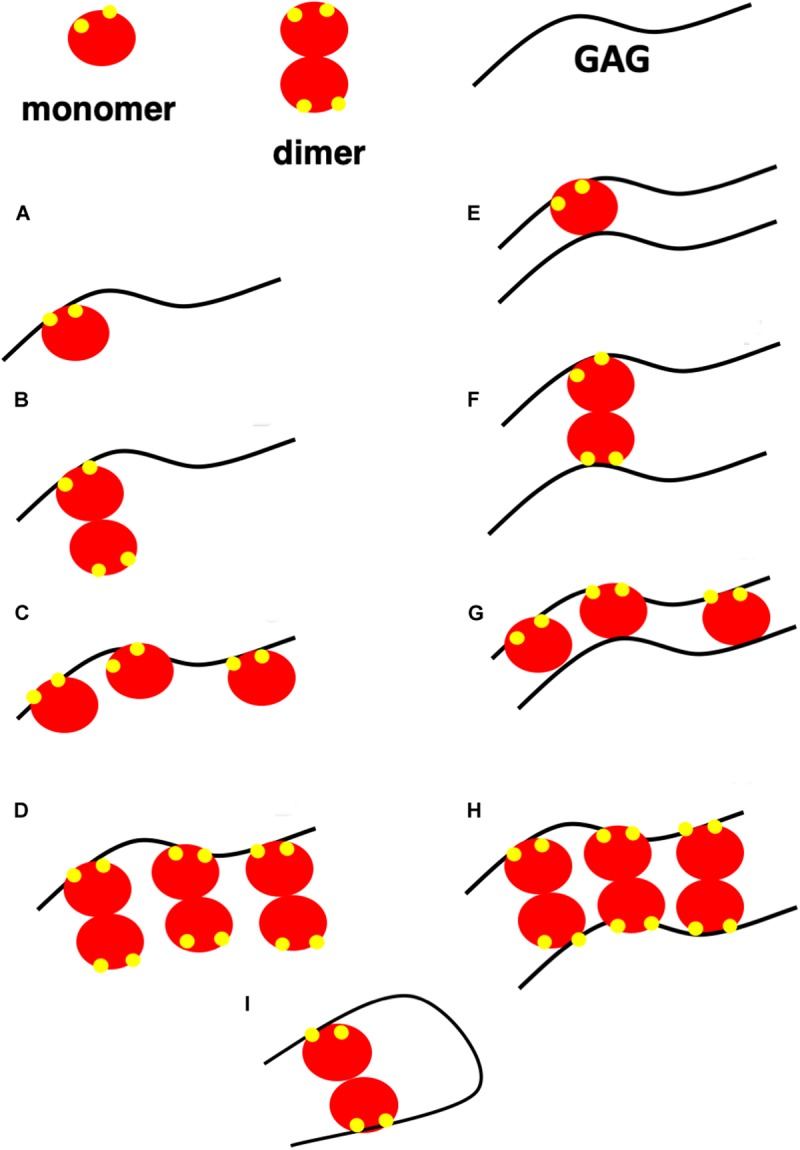
A schematic showing possible GAG-bound ELR chemokine structures. In this schematic, a GAG corresponds to heparin or HS, monomer and dimer corresponds to CXCL5 monomer and dimer, and GAG-binding residues are shown in yellow. (A,B) A single chemokine monomer or dimer binding a single GAG occurs at low chemokine concentrations. With increasing concentration, dimer-bound GAG is favored due to higher binding affinity. (C,D) Chemokines bind GAGs like beads on a string at high chemokine concentrations. Of the two, model (D) is favored due to higher binding affinity of the dimer. (E–H) Chemokines bind two GAGs within a PG or between PGs. Of the different models, models E and G are unlikely as a monomer has only one GAG binding site. (I) Horseshoe model of HS binding to a chemokine dimer. HS structure consists of sulfated regions (NS) interspersed with non-sulfated regions (NA). HS is of the form NS-NA-NS in the horseshoe model.